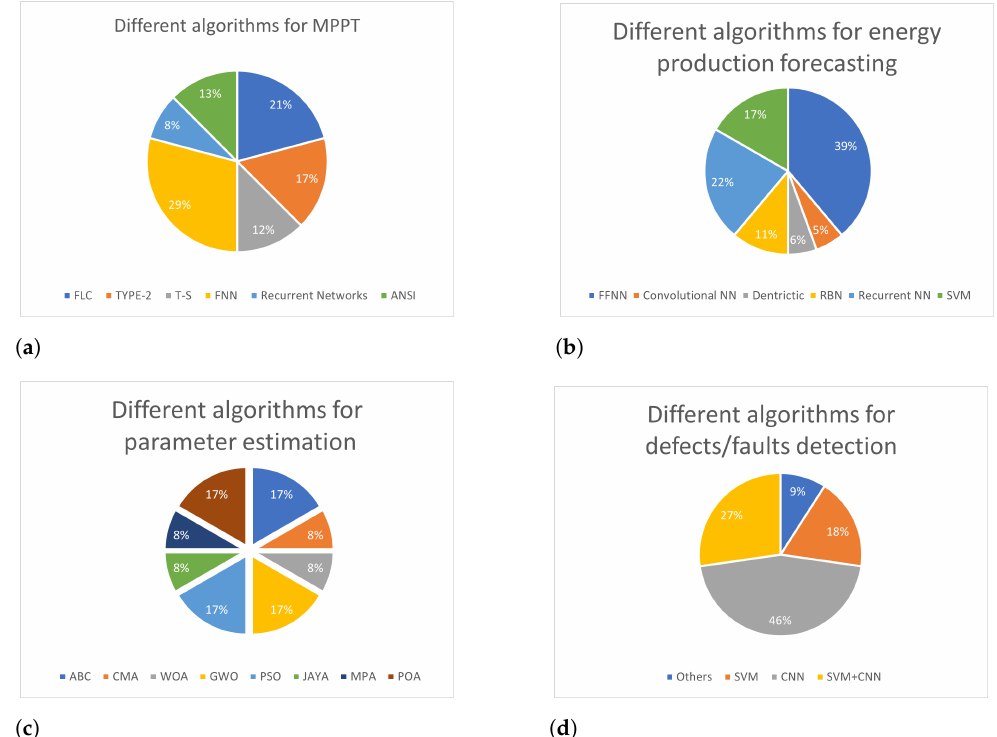
Figure 8. Different algorithms for each of the problems. ( a ) MPPT; ( b ) forecasting; ( c ) parameter estimation; ( d ) defects